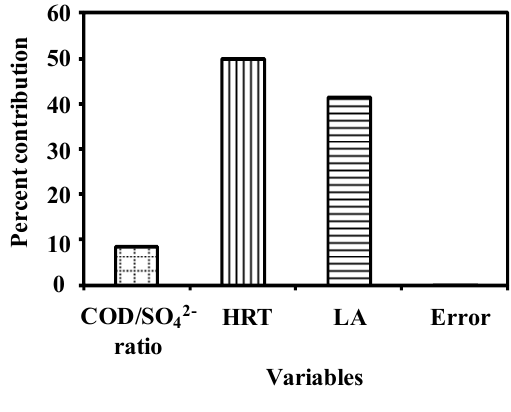
1. Percent contribution of each variable on the sulfate removal rate. (1. HRT = hydraulic retention time; LA = linoleic acid; 2. Percent contribution of